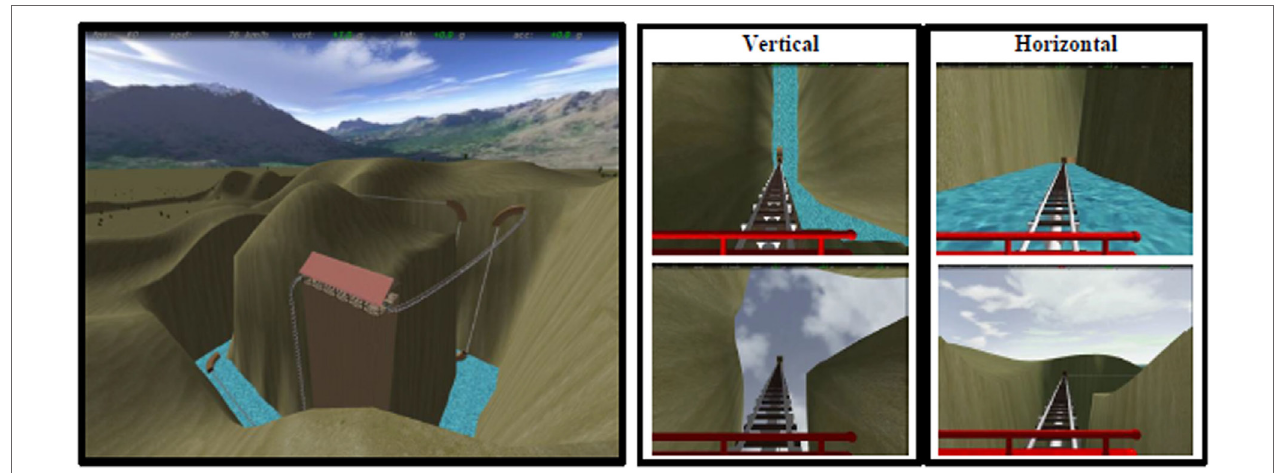
FigUre 1 | Virtual rollercoaster environment showing panoramic overview (left) and still frames from examples of vertical (central) and horizontal (right)